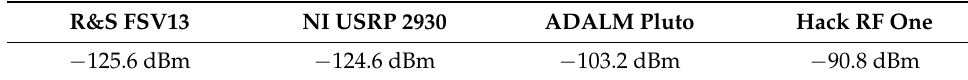
Table 1. Noise power level in a TETRA channel (channel 131, central frequency 393.2875 MHz).